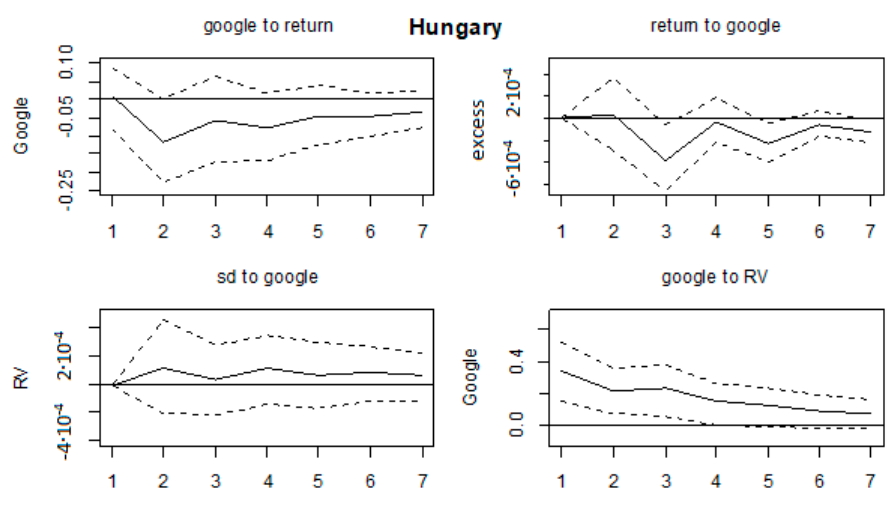
Figure A12. Impulse response functions, Hungary.